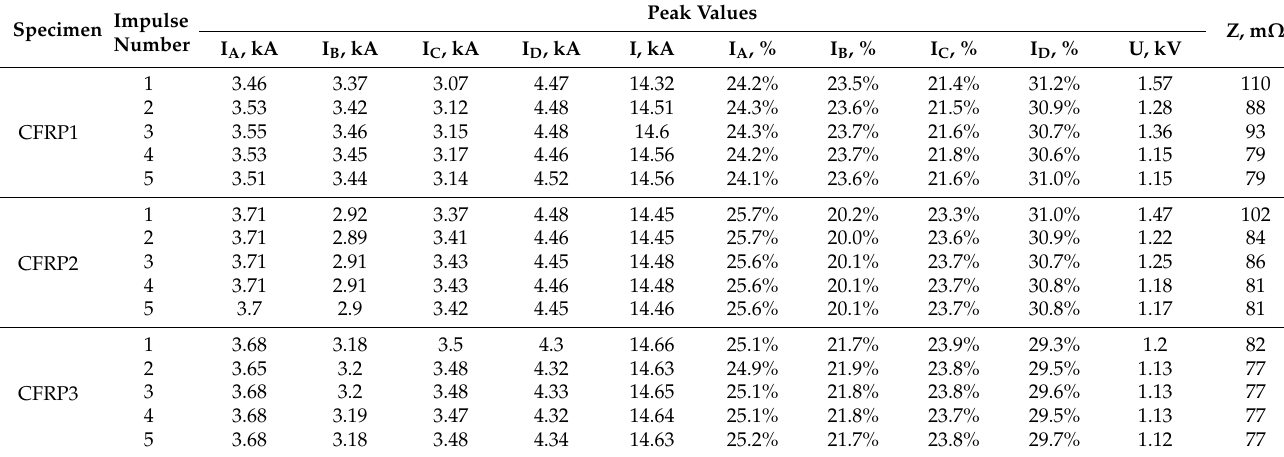
Table 1 summarizes the currents and voltage peaks for each sample. The observed results for individual samples are not as varied as one might expect knowing that each laminate had a different filler. In a percentage comparison (peak value of edge current to total current), it is easier to determine the direction of current flow in the sample. The minor dominance of the current i D (t), followed by i A (t), was noted for all tested laminates. The surge impedance Z presented in Table 1 for each sample was calculated from the relationship of peak voltage U = max ( u ( t )) and peak of total injected current I = max ( i ( t )) as Z = U/I. Table 1. The currents and voltage peak values recorded during testing of three composite samples with lightning-type pulses. Specimen Impulse